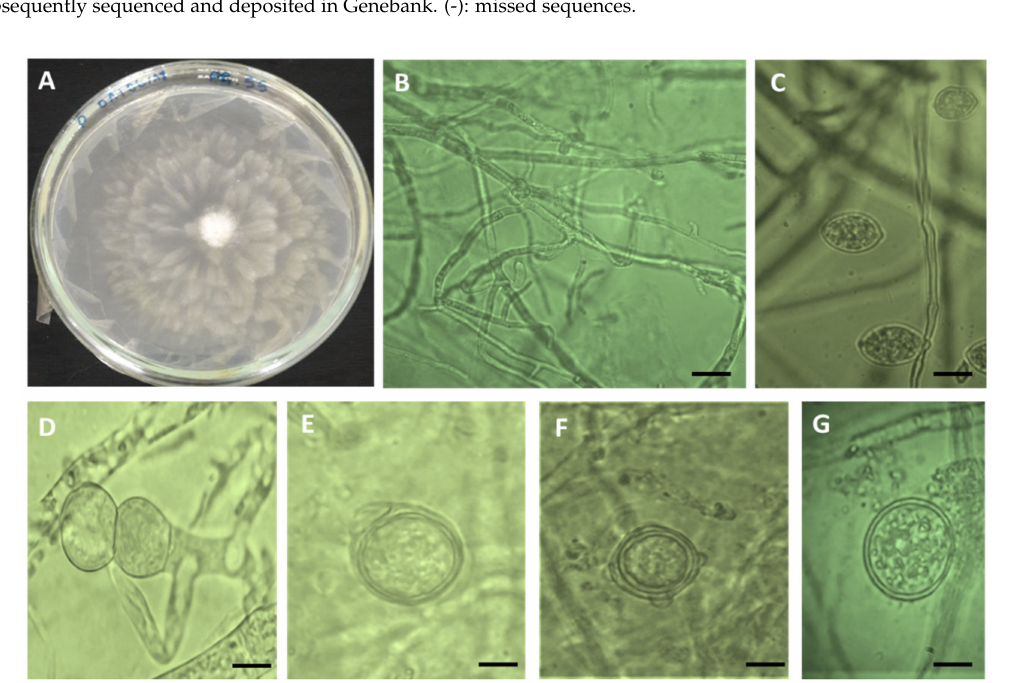
Figure 3. Morphology of Phytopythium vexans : white transparent colony on PDA medium ( A ), coenocytic hyphae ( B ), sporangia ( C ), double oospore ( D ), oogonium with single lobe branched antheridium ( E ), oogonium with two lobes branched antheridium ( F ), and thick-walled chlamydospores ( G ). Bar scale = 15 µ